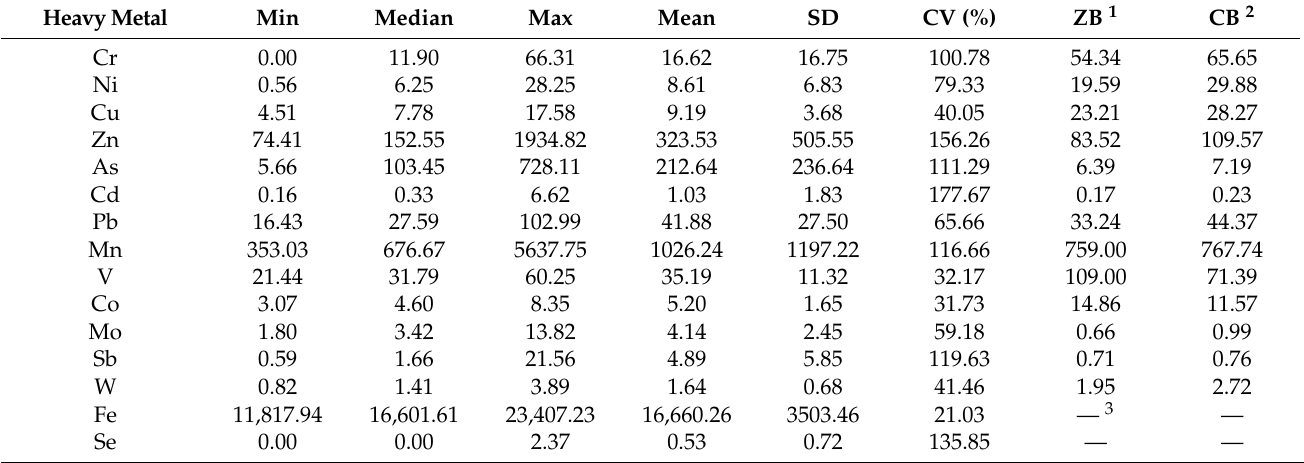
Table 2. Descriptive statistics on the content of heavy metal in surface sediments (unit: